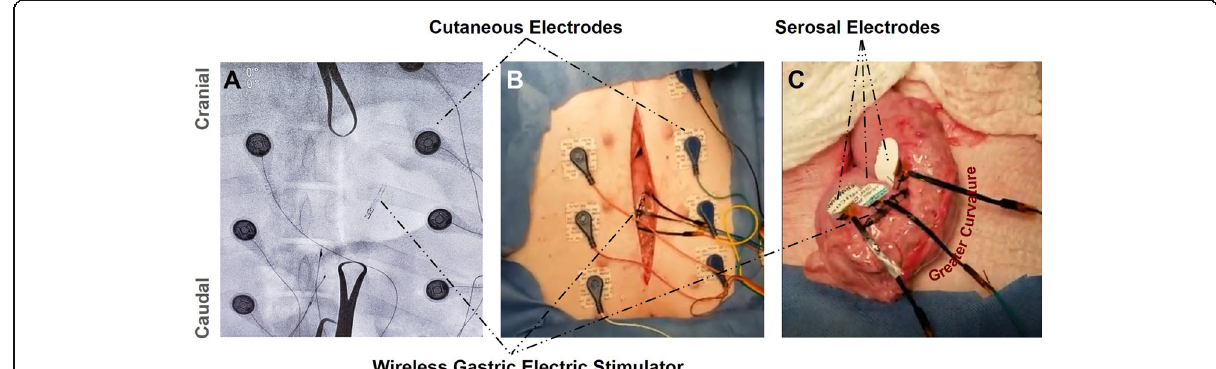
Fig. 3 Swine Study Design. A Radiographic image of the swine abdomen with implanted gastric pacer and cutaneous EGG recording electrodes demonstrates minimal device footprint upon implantation to reduce potential complications. B Photo demonstrating surgical incision site and relative position of the pacer from the skin surface where the pacer transmitter was positioned during stimulation. C The segment of the stomach where the wireless pacer and serosal recording electrodes were sutured demonstrate device position along the greater